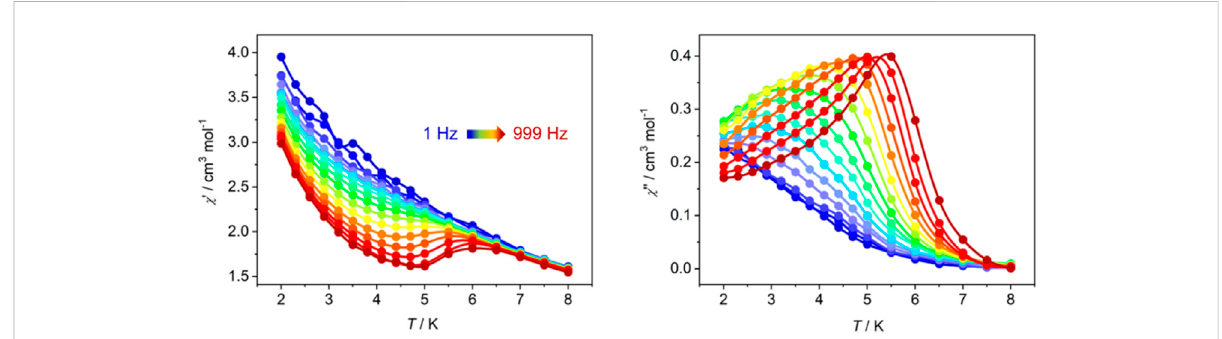
FIGURE 5 Temperature-dependent χ ′ (left) and χ ″ (right) ac susceptibilities for Dy-CP measured in 1.5 kOe dc fi eld.